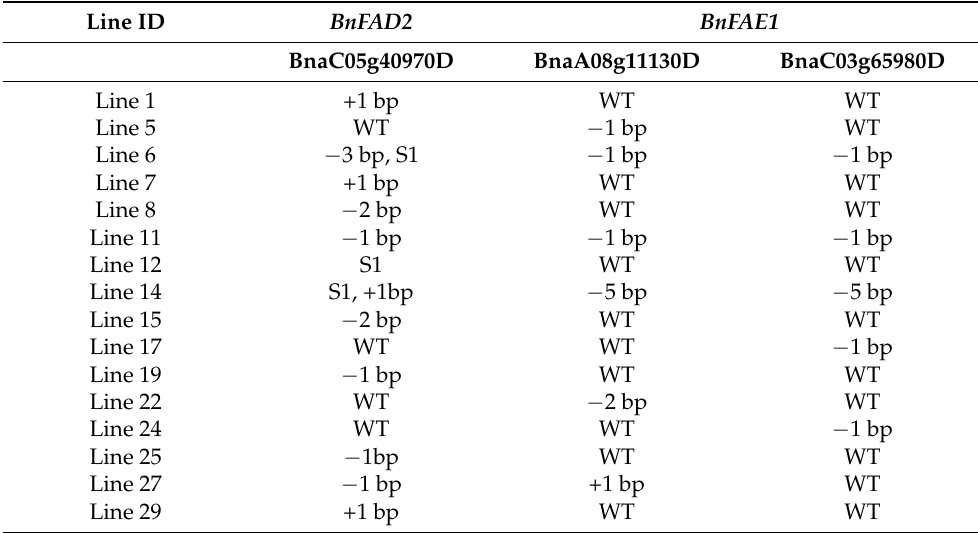
Table 1. Genotype of BnFAD2 and BnFAE1 genes in T 0 edited